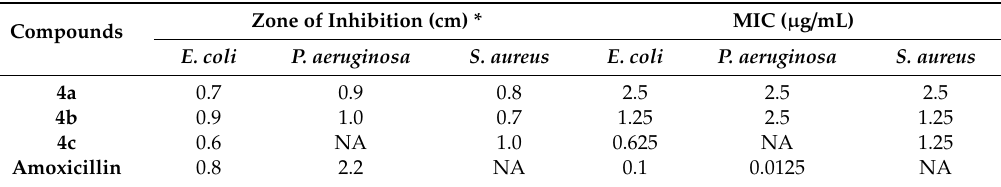
Table 1. Agar well di ff usion method–zone of inhibition and minimum inhibitory concentration (MIC, µ g / mL) of rhodanine azos 4a–c . Zone of Inhibition (cm) * MIC ( µ g / Compounds